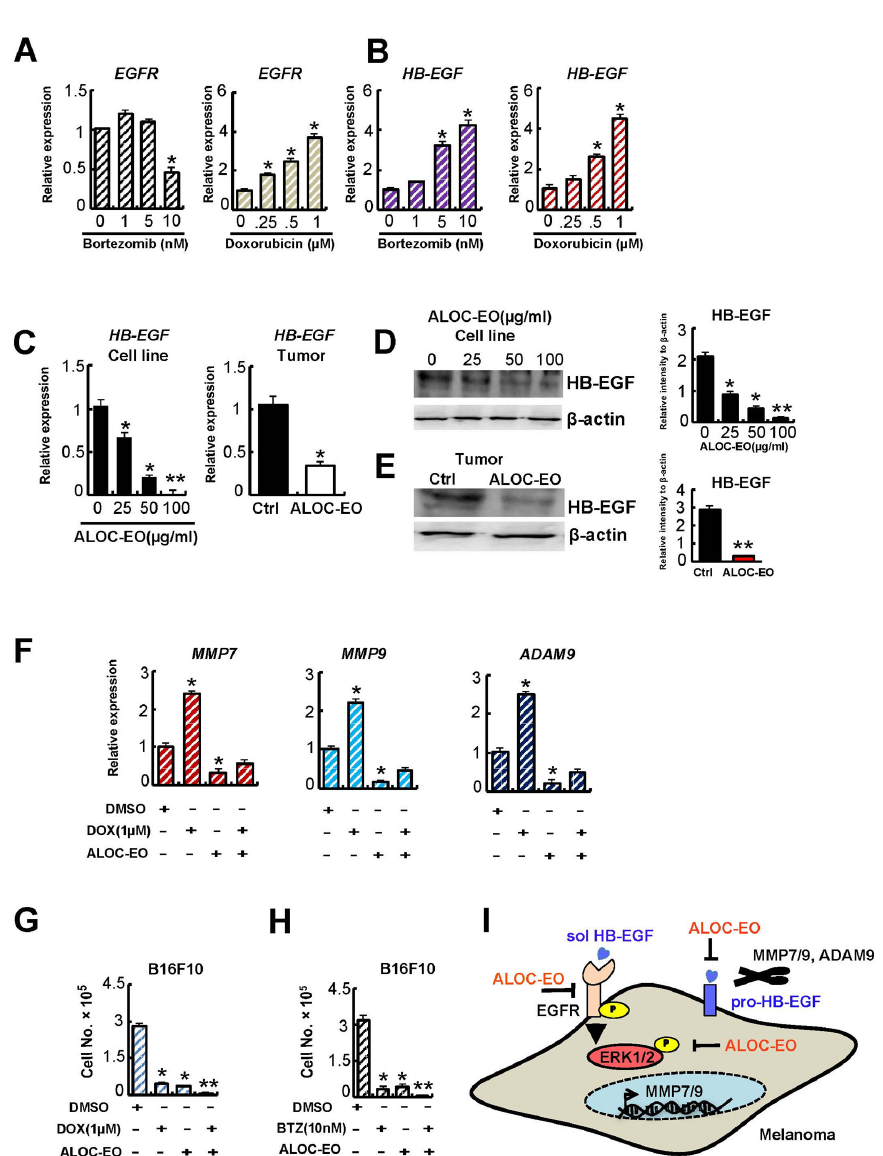
Figure 4. Chemotherapy-induced HB-EGF-EGFR upregulation is blocked by ALOC-EO and improves chemo-sensitivity. ( A ) Fold change expression of murine HB-EGF and ( B ) EGFR in B16F10 cells treated with indicated concentrations of the antitumor drugs bortezomib or doxorubicin, as a carrier by qPCR (A; n = 3/group). ( C – E ) HB-EGF expression was determined after ALOC-EO treatment for 24 h in B16F10 cells and tumor tissues retrieved from tumor-bearing mice treated with or without ALOC-EO at day 12 by qPCR (C; n = 3/group) by Western blotting analysis ( D , E ). Right panel: The histograms represent the signal intensity of the indicated protein bands in arbitrary units after normalization with the signal intensity of β -actin internal control for each sample. Values are means and SEM of two independent experiments. ( F – H ) B16F10 cells were treated with BTZ ( G ) or doxorubicin ( F , H ) at indicated concentration in the presence or absence of 100 µ g/mL ALOC-EO. ( F ) Fold expression of MMP7/9 , and ADAM9 in cells treated with indicated drug combinations as determined by qPCR. ( G , H ) Viable cells were counted after 24 h, using the trypan blue exclusion assay (n = 6). The results of three independent experiments performed in triplicates are expressed as fold change according to 2- ∆∆ CT method using β -actin as calibrator. Transcript levels were normalized to β -actin (n = 3/group). ( I ) Proposed mode of action for ALOC-EC in melanoma: ALOC-EO can block EGFR and ERK1/2 phosphorylation, leading to the reduced expression of MMP7/9 and ADAM9. Not shown in this study is that these proteases are known to enhance the shedding of the EGFR ligand HB-EGF. Abbreviations: ALOC-EO, Aloysia citrodora essential oil; EGFR, epidermal growth factor receptor; ERK1/2, extracellular signal-regulated kinase; MMP7, matrix metalloproteinase-7, matrix metalloproteinase9 (MMP9), a disintegrin and metalloproteinase domain-containing protein 9 (ADAM9). * p < 0.05; ** p <